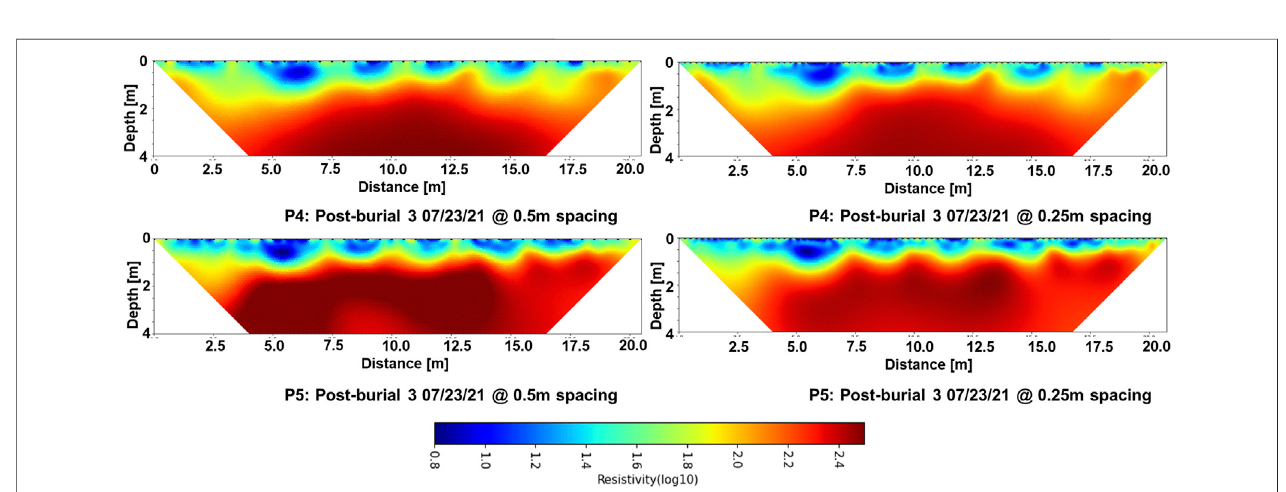
FIGURE9| Comparisonof2Dresistivitydistributionfortransects4(top)andtransect5(bottom)withdataacquiredusingaunitelectrodespacingof0.5 m(left)and 0.25 m (right).